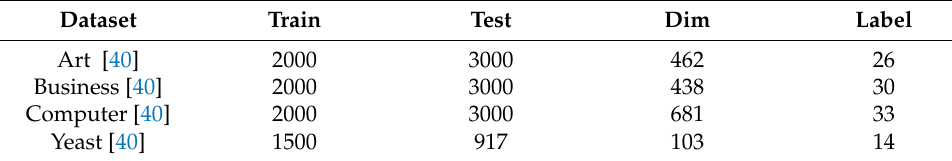
Table 4. Details about the multi-label classification